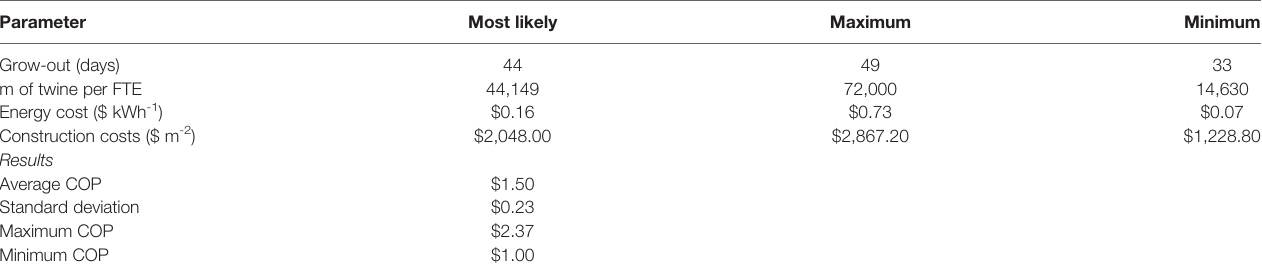
TABLE 3 | Results of a Monte Carlo analysis (1,000 iterations) in which the grow-out duration (days), labor requirements (m of twine per FTE employee), energy costs ($ kWh -1 ), and facility construction costs ($ m -2 ) were all modeled as triangularly distributed random variables. Parameter